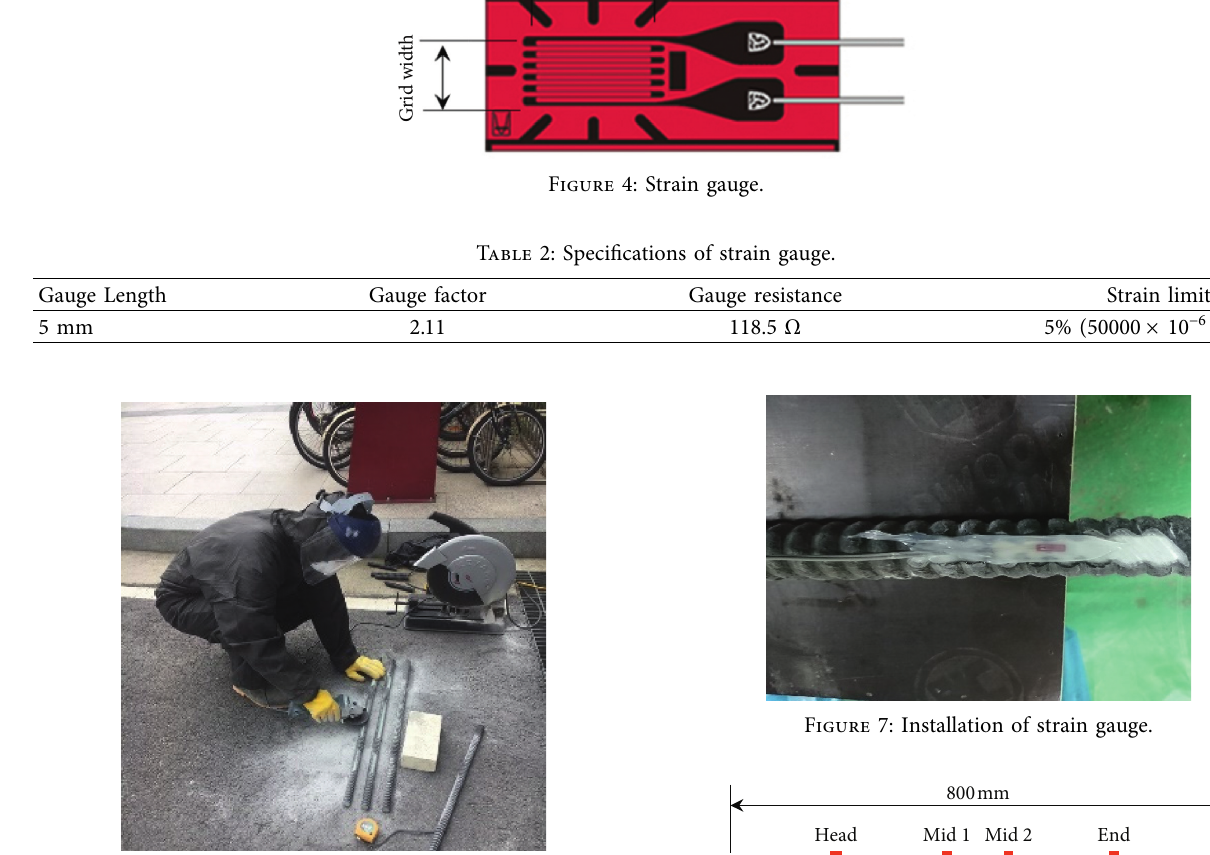
Figure 5: Flattening operation for attaching strain gauges.